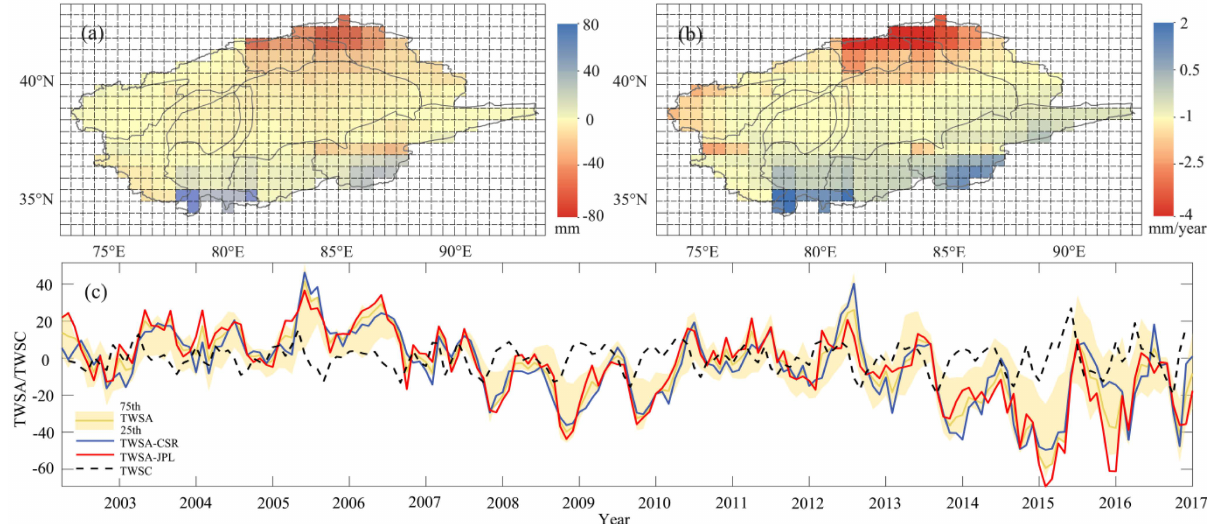
Figure 4. The spatial–temporal distribution of Gravity Recovery and Climate Experiment (GRACE) terrestrial water storage anomalies (TWSA) derived from Jet Propulsion Laboratory (JPL) and Center for Space Research (CSR) during the period 2002–2017. (( a ): spatial distribution of TWSA; ( b ): changing rate of annual TWSA; ( c ): temporal changes of average TWSA(mm) and TWSC(mm/month)).